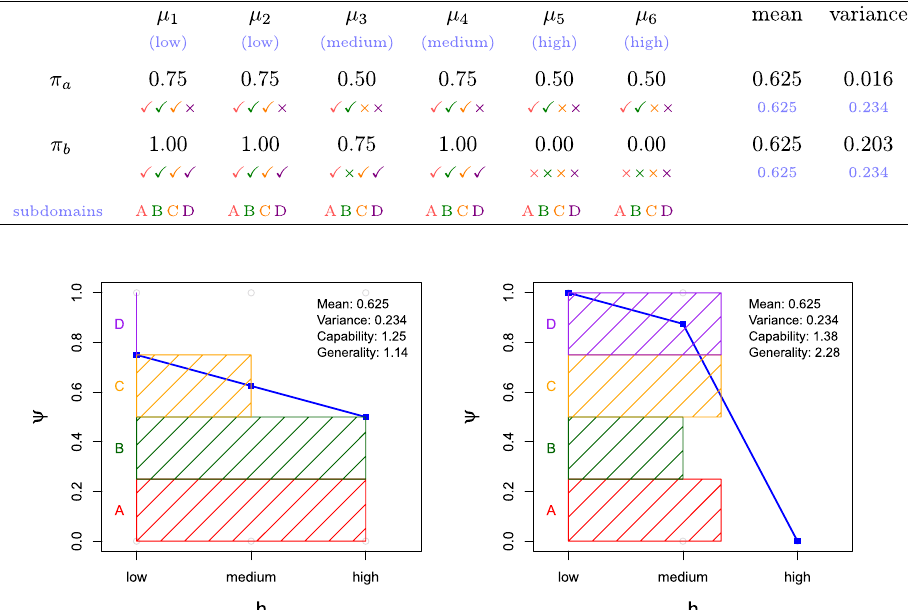
Figure 1. The role of difficulty when Agent Characteristic Curves (ACCs) are derived from a result matrix, and the new metrics represented in the spread vs capacity plot. Top: Response matrix R with cells r j , i , where rows represent the agents (also referred to as respondents or subjects) and columns represent the tasks (also referred to as items or instances, depending on the aggregation). The difficulty of each task (low, medium or high) is shown in parentheses just below the name of the task. While the subdomains may not be known, if we cluster some questions in a particular way (A B C D), we see that one agent ( π a ) completely neglects subdomain D. Bottom: We show the responses of these two different agents corresponding in terms of difficulty ( h ) on the x -axis. Left: π a . Right: π b . We also highlight how the two agents fare for the four domains in which the items are grouped. Having the same average result (0.625), which agent, π a or π b , is more